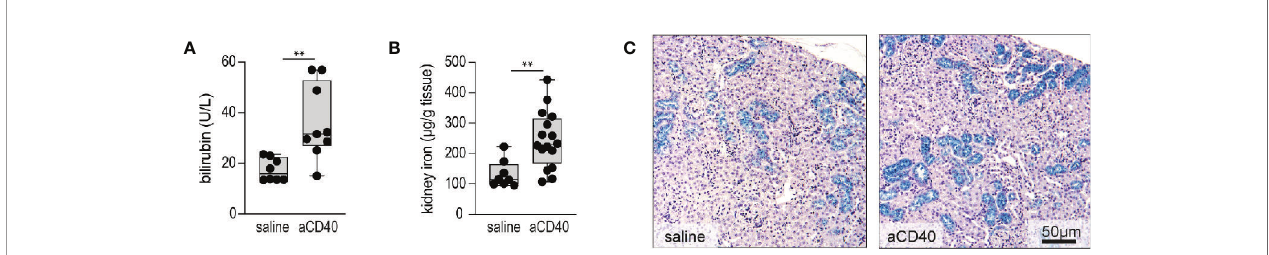
FIGURE 2 | Accelerated hemolysis after anti-CD40 administration in sickle cell mice. (A) Plasma bilirubin in saline versus anti-CD40 treated sickle cell mice (groups; saline n=8, aCD40 n=9). (B) Iron concentration measured by the ferrozine method in kidneys of saline versus anti-CD40 treated sickle cell mice (groups; saline n=8, aCD40 n=16). (C) Representative histology images for Perls staining of kidney sections from saline and anti-CD40 treated sickle cell mice. Blue color represents non- heme iron deposits, mainly seen in proximal tubules. Scale bar 50 µm. Each data point represents a single mouse. ** p <0.01, * p <0.05, all comparisons between